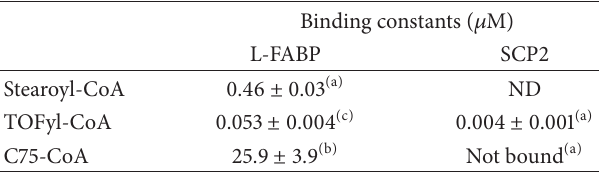
Table 2: Binding parameters for L-FABP and SCP2 to CoA interact- ing with fatty acid and fatty acid synthesis inhibitor CoA